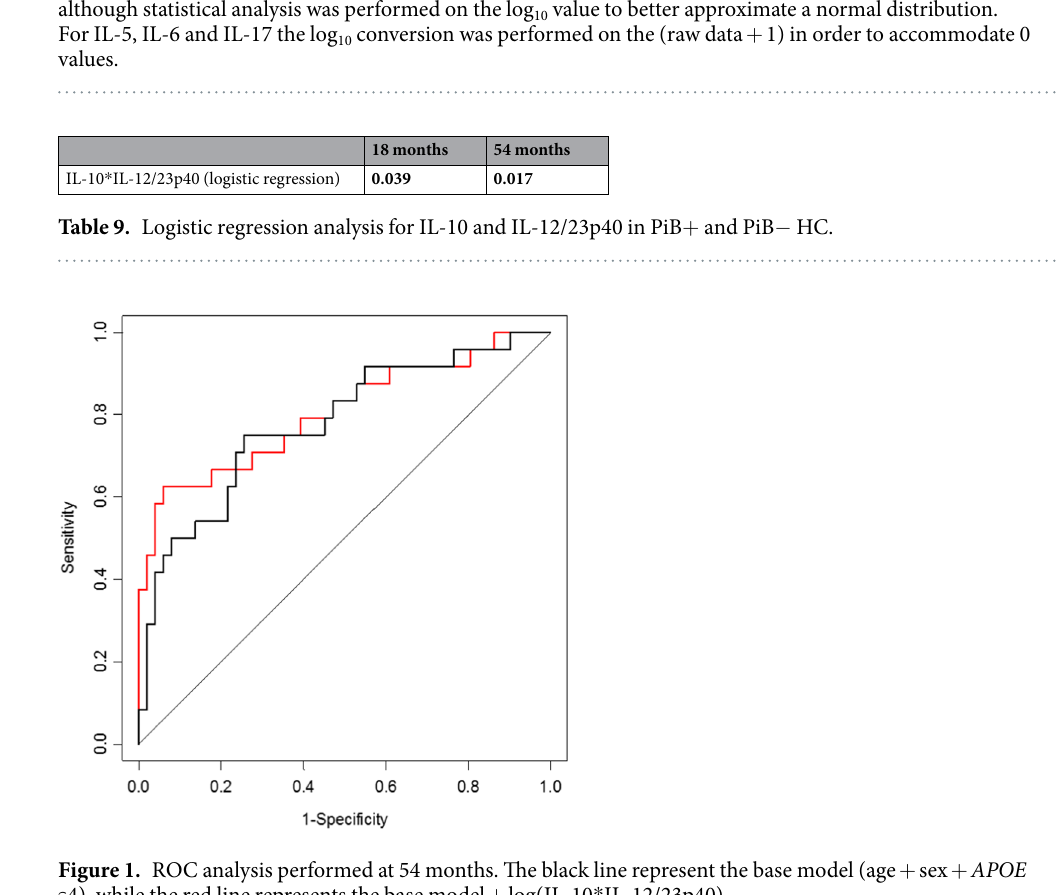
6 Scientific RepoRts | 7: 14057 | DOI:10.1038/s41598-017-14020-9